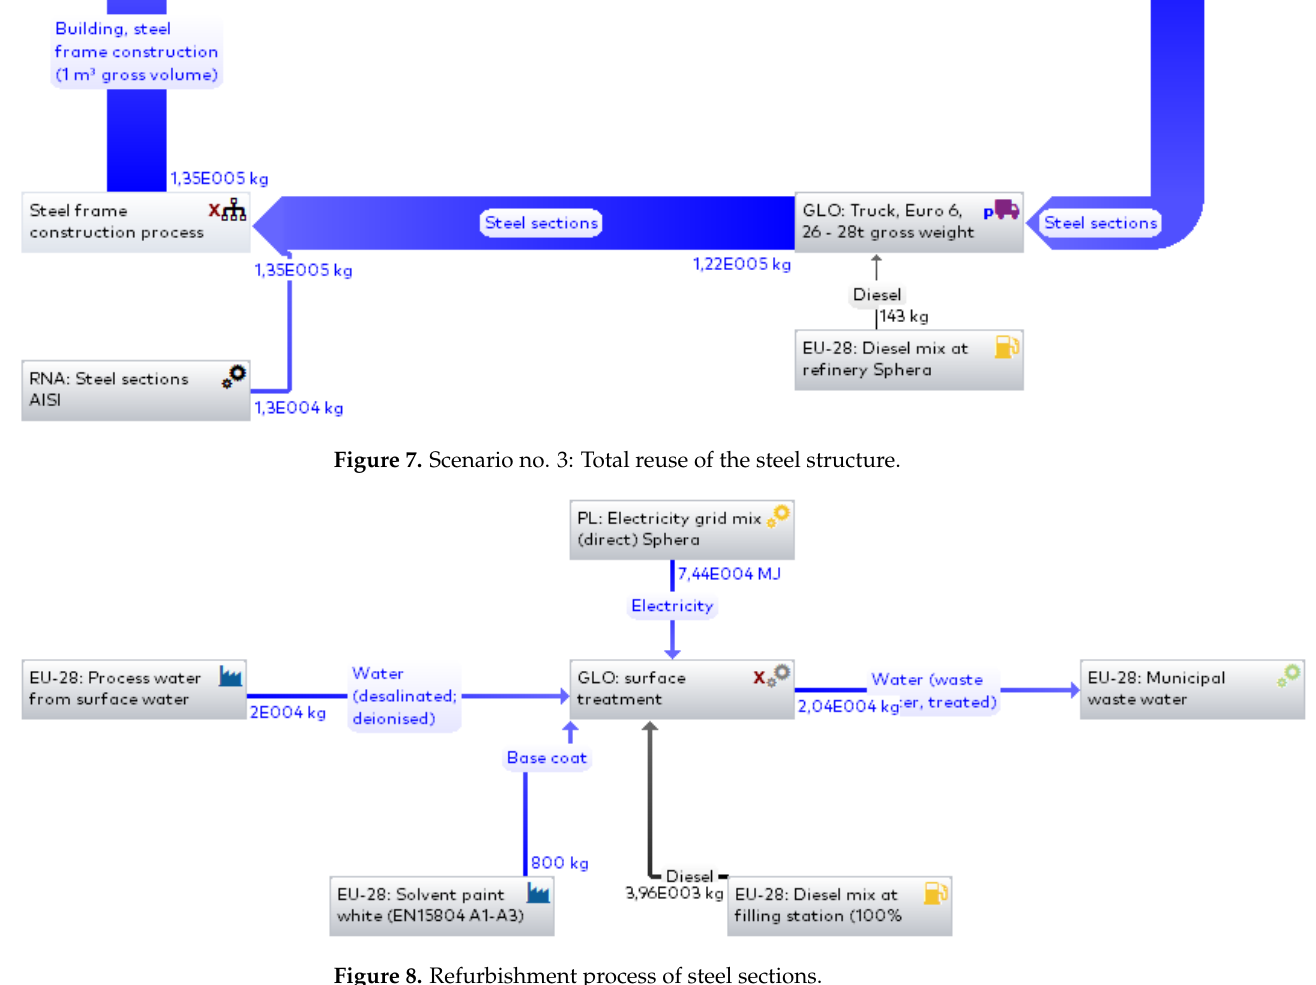
Figure 9. GWP 100 years values in three scenarios [t CO 2 eq.]. 196.3 t